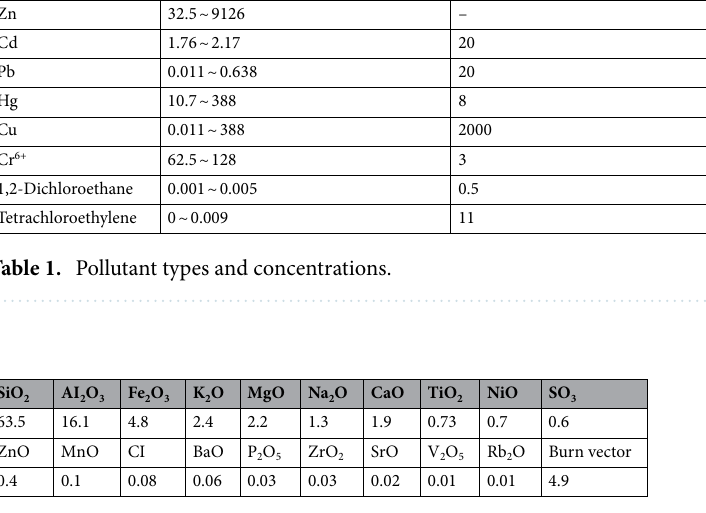
Table 2. Chemical composition of contaminated soil (mg/kg).